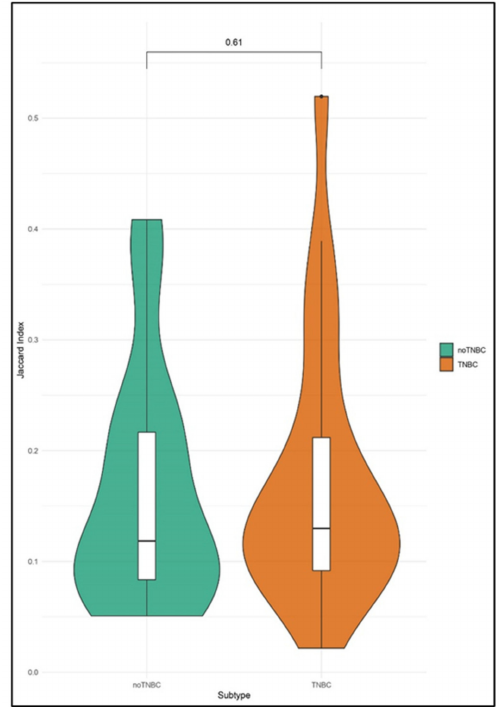
Figure 2. Violin plots showing the distribution of the Jaccard Indexes (JIs) computed by comparing the copy number alteration (can) profile of single circulating tumor cells (CTCs) and matched tumor tissue in non-triple negative breast cancer (TNBC) against TNBC.